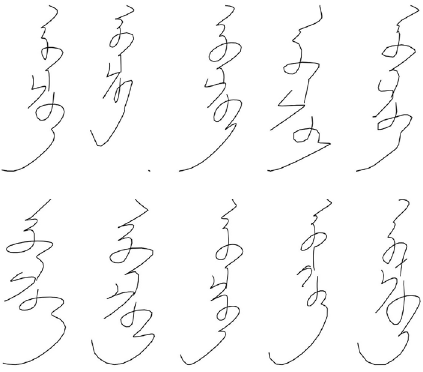
Figure 7. Some different handwriting style samples in MOLHW.